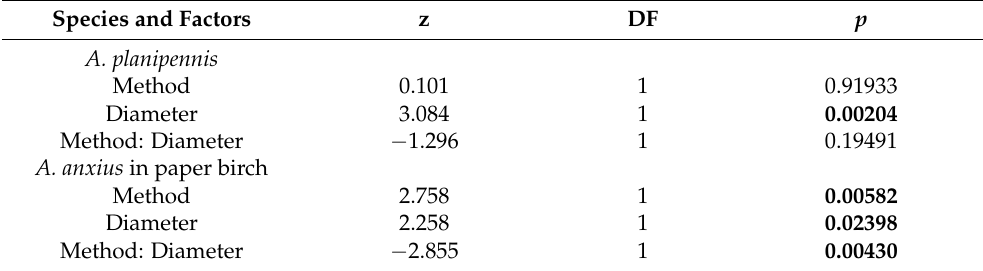
Table 2. Statistical values from the generalized linear mixed models (Poisson distribution) for the number of Agrilus immatures detected with CT-scan and debarking. p values considered significant (<0.05) are shown in